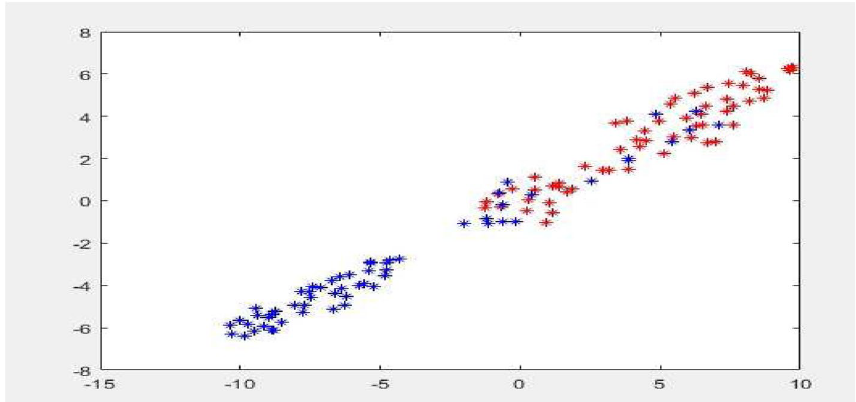
Fig. 19 Clusters from 60-natural spectral descriptors and 60 print spectral descriptors. N S generated per image statistic) and scan parameters were: Image-statistic or patch size W image-statistic, L W 2 =